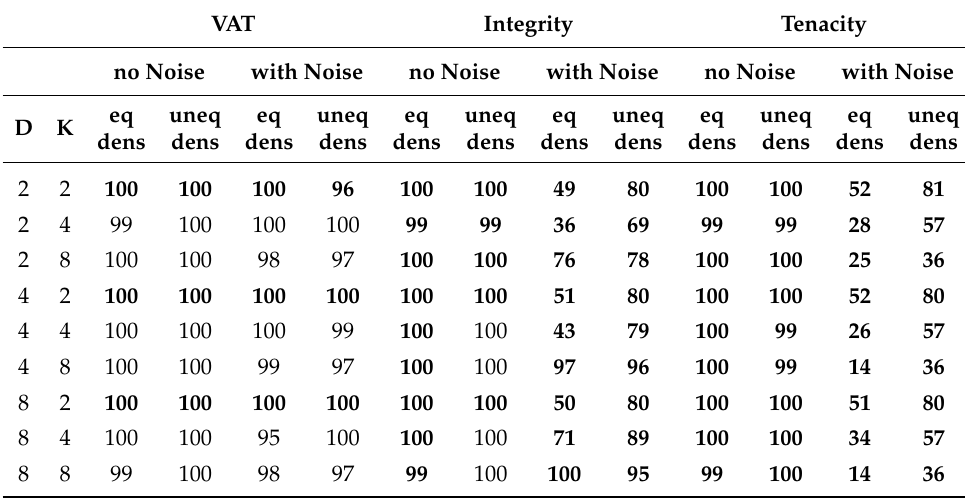
Table 7. Percent accuracy for four variations of synthetic datasets. Bold text indicates one-step